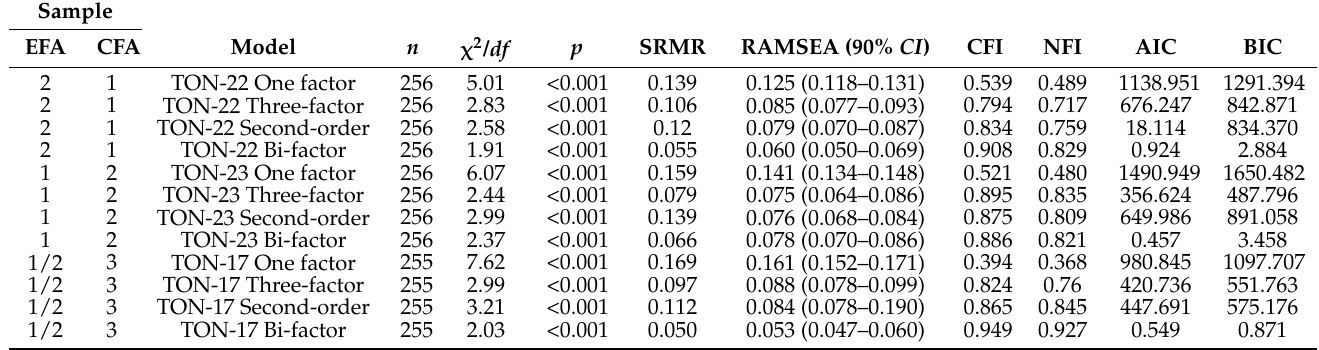
Table 2. Fit indices for the TON-22, TON-23, and TON-17 factor models.